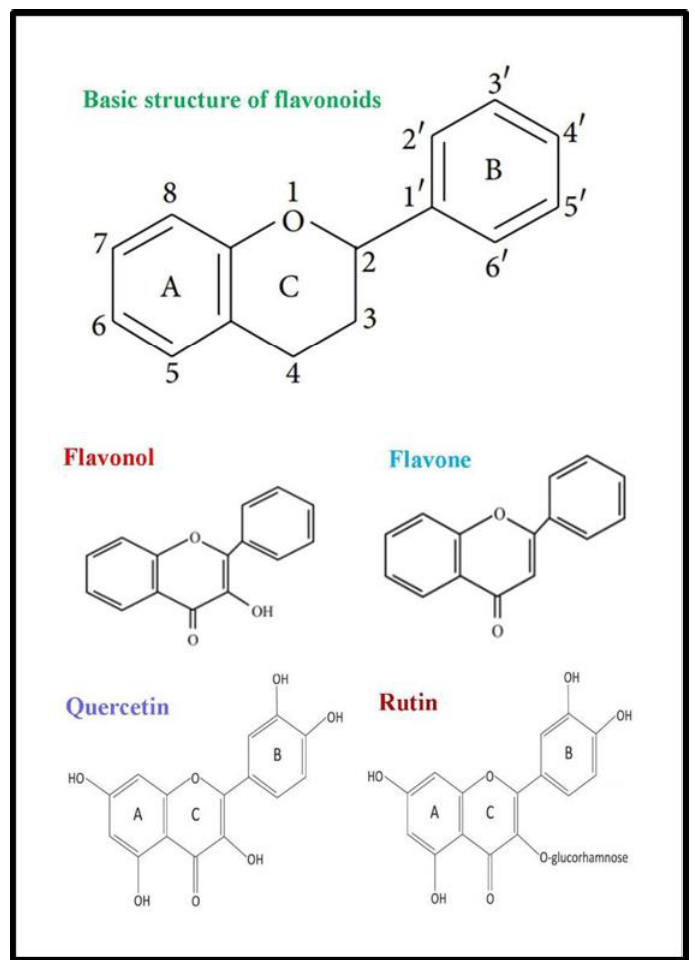
Figure 2. Basic structure of flavonoids present in mulberry leaves.